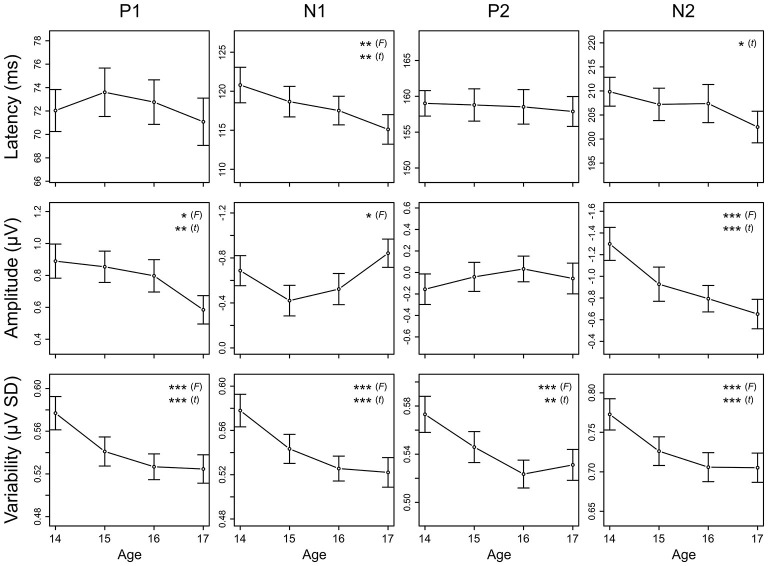
Longitudinal trajectories of CAEP measures. Mean and standard error values are plotted across all ages for peak latency, mean amplitude, and variability of P1, N1, P2, and N2. Measures for which the ANOVA F-test across all ages or the t-test between ages 14 and 17 showed significant maturation effects are indicated by asterisks (* = p < 0.05, ** = p < 0.01, *** = p < 0.001). These data are also reported in Tables 3, 4, and 5. Negative is plotted up for N1 and N2 mean amplitude so that up consistently represents increased magnitude across all plots.